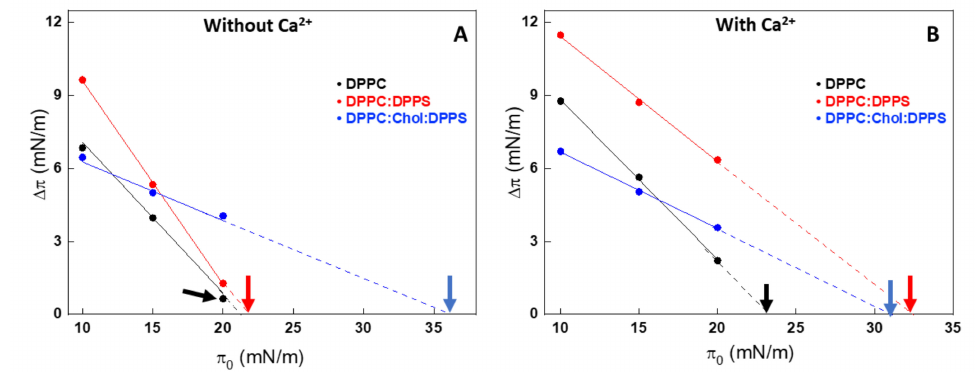
Figure 2. Changes in the surface pressure ( ∆ π ) due to the injection of AnxA6 as a function of the initial surface pressure ( π 0 ) of Langmuir monolayers in the absence ( A ) and presence of 2 mM Ca 2 + ( B ) for 1,2-dipalmitoyl- sn -glycero-3-phosphocholine (DPPC) (black dots), 9:1 DPPC:1,2-dipalmitoyl- sn -glycero- 3-phospho-L-serine (DPPS) (red dots) and 5:4:1 DPPC:cholesterol (Chol):DPPS (blue dots) monolayers as a consequence of interaction with AnxA6. The intercept with abscissa is the exclusion pressure ( π exc ) and is indicated by the arrows. The analyses were adjusted to π 0 close to 10, 15, and 20 mN /